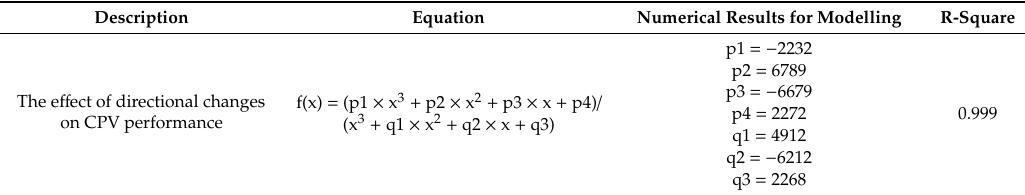
Figure 9. Changes in CPV performance as a result of 0.5° modifications in direction compared to the FP (CPV cell diameter: 3 mm). Table3. TheeffectofdirectionalchangesonCPVperformance(x = changeinorientation( ◦ );f(x) = percentage value of the performance compared to the FP) (CPV cell diameter: 3